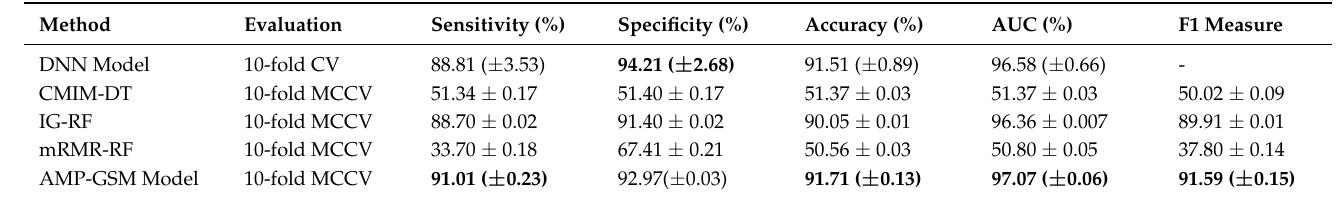
Table 9. Performance evaluation of AMP-GSM with a DNN model for Dataset 2 [33].